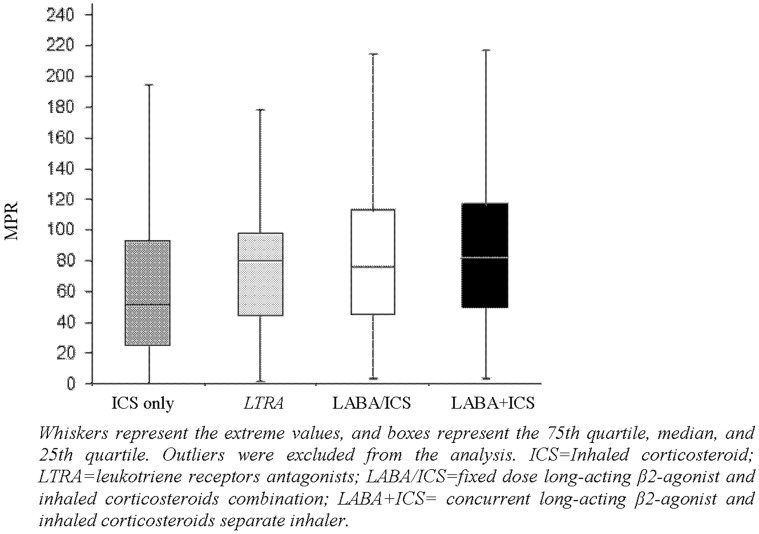
Box plot for the distribution of Medication Possession Ratio of prescribed asthma controller medications.Whiskers represent the extreme values, and boxes represent the 75th quartile, median, and 25th quartile. Outliers were excluded from the analysis. MPR =  Medication possession ratio; ICS = Inhaled corticosteroid; LTRA = leukotriene receptors antagonists; LABA/ICS = fixed dose long-acting β2-agonist and inhaled corticosteroids combination; LABA+ICS =  concurrent long-acting β2-agonist and inhaled corticosteroids separate inhaler.